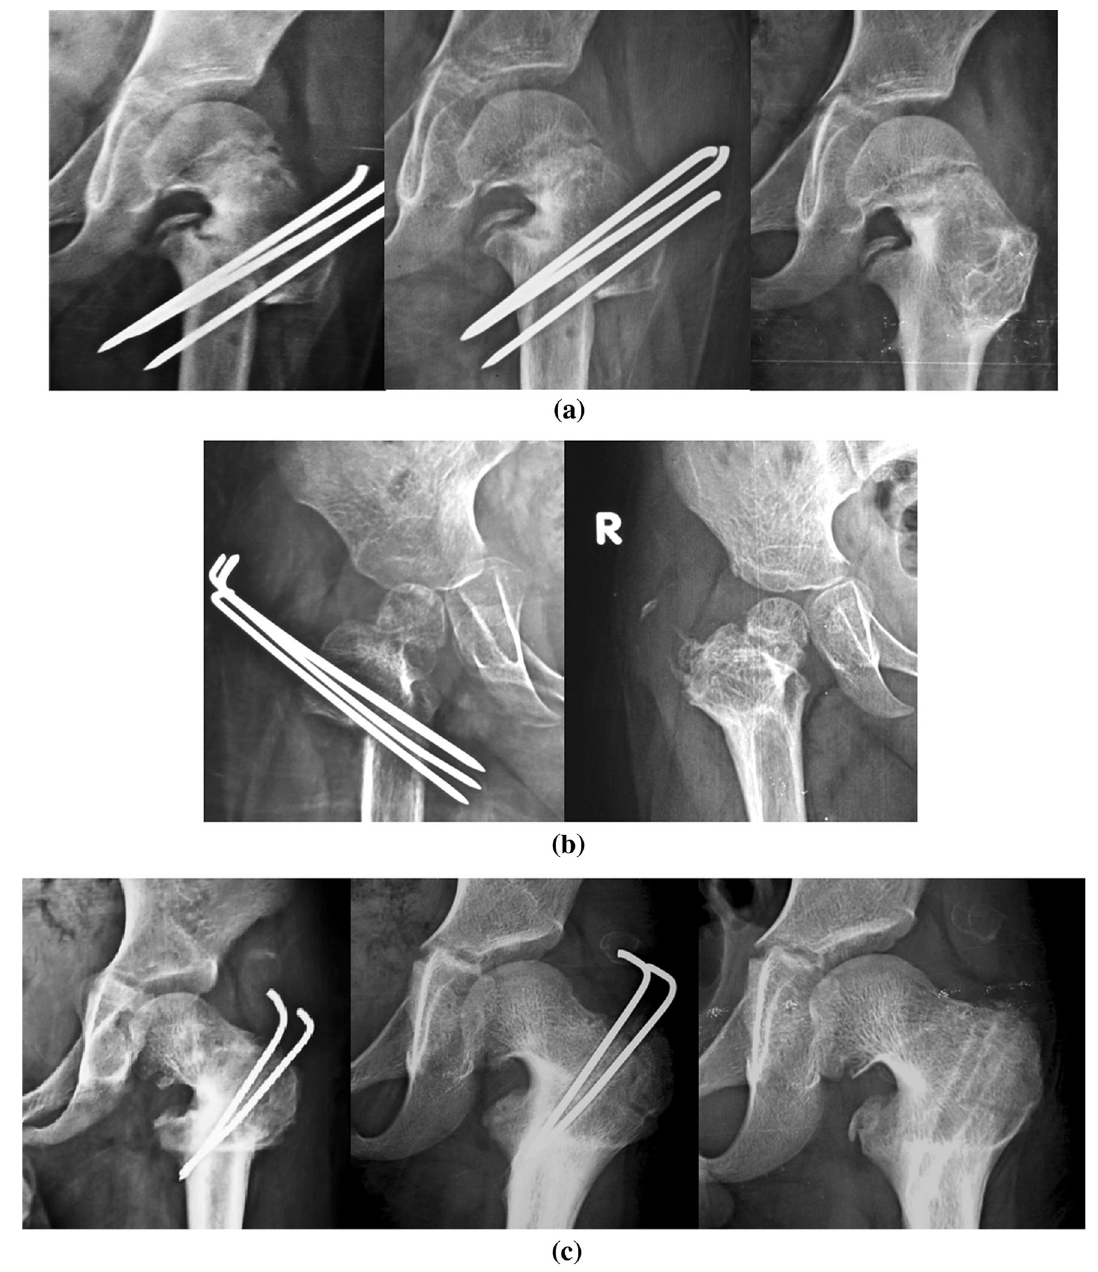
Fig. 11 Remodeling improved the overall alignment of the operated side during follow-up. a Progressive remodeling had effectively corrected the medial displacement of the distal fragment after 27 months postoperatively. b Progressive remodeling had effectively